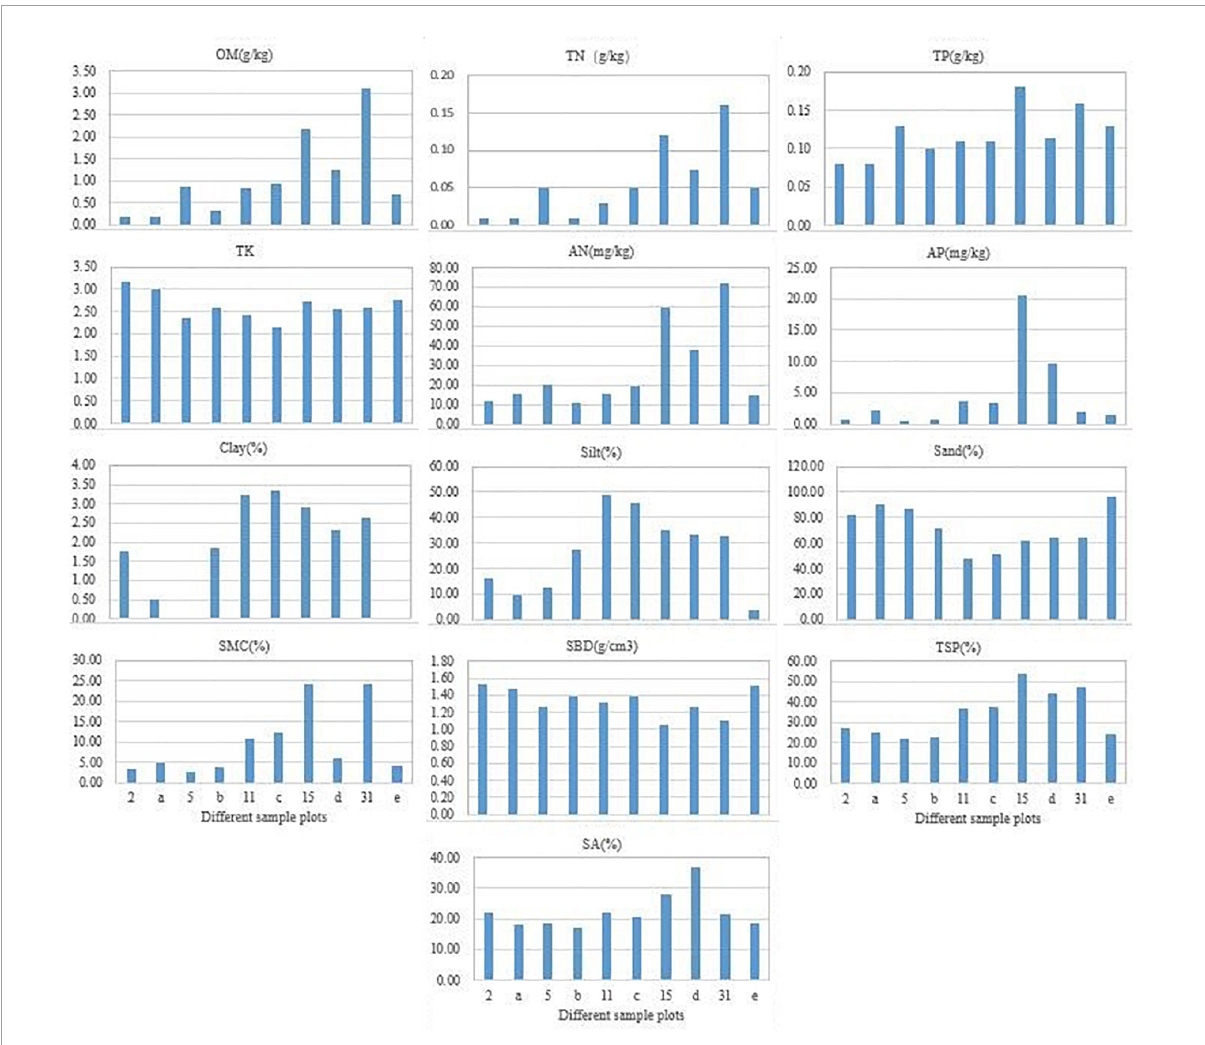
FIGURE3 Statistical chart of the soil physical and chemical index characteristics of the different afforestation years. OM, soil organic matter (g/kg); TN, total nitrogen (g/kg); TP, total phosphorus (g/kg); TK, total potassium (g/kg); AP, available phosphorus (mg/kg); AN, alkaline hydrolyzed nitrogen (mg/kg); clay is clay (%); silt powder (%); sand is sand grains (%); SMC, soil water content (%); SBD, soil bulk density (g/cm 3 ); TSP, soil total porosity (%); SA, soil aeration